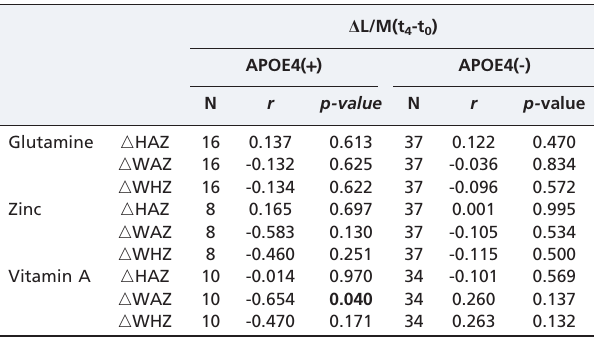
Table 4 - Pearson correlations between the change in the lactulose:mannitol (L/M) ratio (an intestinal permeability indicator) during the initial 4 months of nutritional supplementation and D HAZ* (t 4 -t 0 ), D WAZ* (t 4 -t 0 ) and D WHZ* (t 4 -t 0 ) according to APOE4